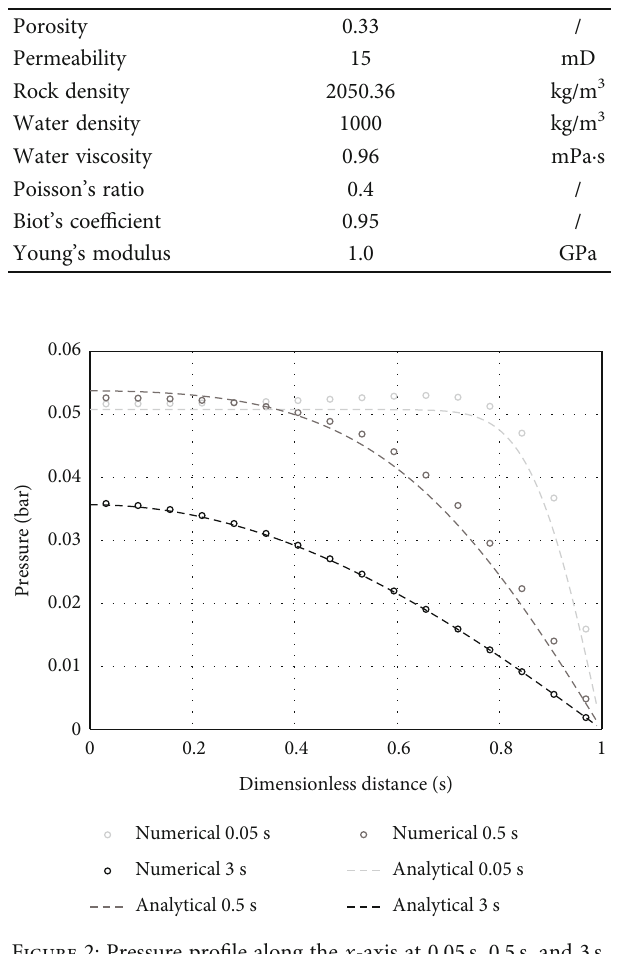
Figure 2: Pressure pro fi le along the x -axis at 0.05s, 0.5 s, and 3 s.